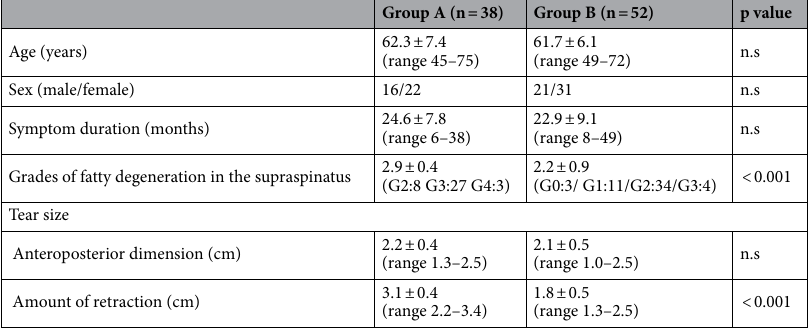
Table 1. Patient demographics of both groups. Values are presented as means and standard deviations. Fatty infiltration was measured according to the Goutallier